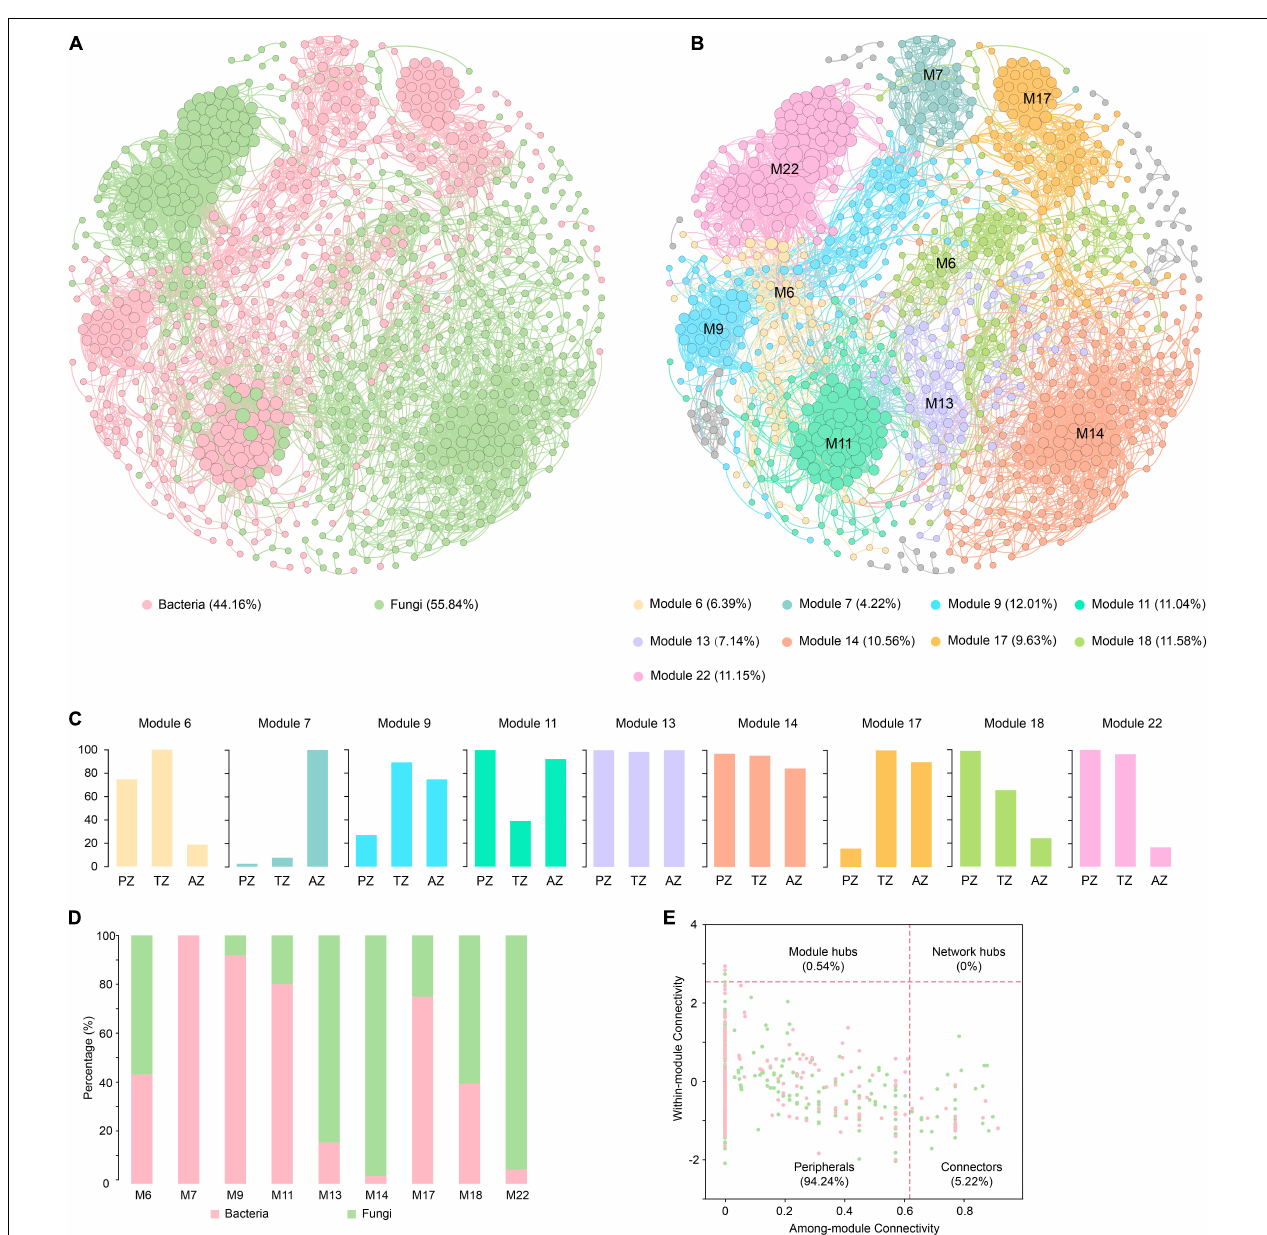
FIGURE 5 | Co-occurrence networks of bacterial and fungal communities of weathered rocks in the Heshang Cave colored by bacteria and fungi (A) and by modules (B) . The proportion of ASVs/OTUs based on sampling zonation in each module (C) . The proportion of bacterial ASVs and fungal OTUs in each module (D) . The within-module connectivity ( Zi )–among-module connectivity ( Pi ) plot shows distribution of ASVs/OTUs according to their module-based topological roles in the co-occurrence networks of bacterial and fungal communities (E) . Each dot represents an ASV in the dataset of bacteria (pink) or an OTU of fungi (green). PZ: photic zone, TZ: twilight zone, AZ: aphotic